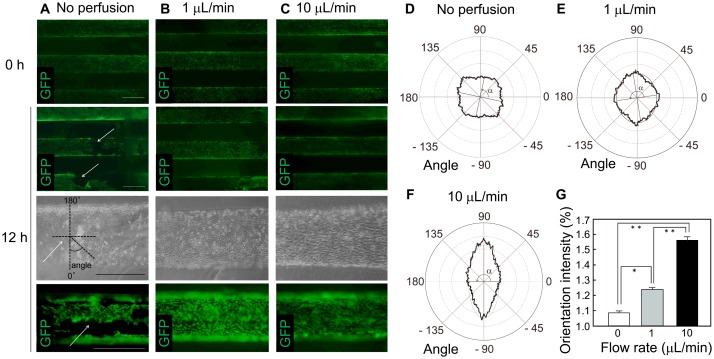
Effects of shear stress on endothelial cell alignment.(A–C) HUVEC layers electrochemically transferred to the internal surfaces of microchannels and cultured in chambers for 12 h in the presence or absence of culture medium perfusion. HUVECs were partially detached in the absence of perfusion (A, arrows), but continued to cover the surface at a flow rate of 1 μL/min (B) and 10 μL/min (C). Scale bars, 500 μm. (D–G) Quantification of HUVEC orientation with respect to flow direction after 12 h of culture in the presence or absence of perfusion. The angle and mean amplitude at 0 μL/min (D), 1 μL/min (E), and 10 μL/min (F), and comparisons of the orientation intensity (G). *P < 0.05, **P < 0.01. Error bars indicate standard deviations calculated from three independent experiments.